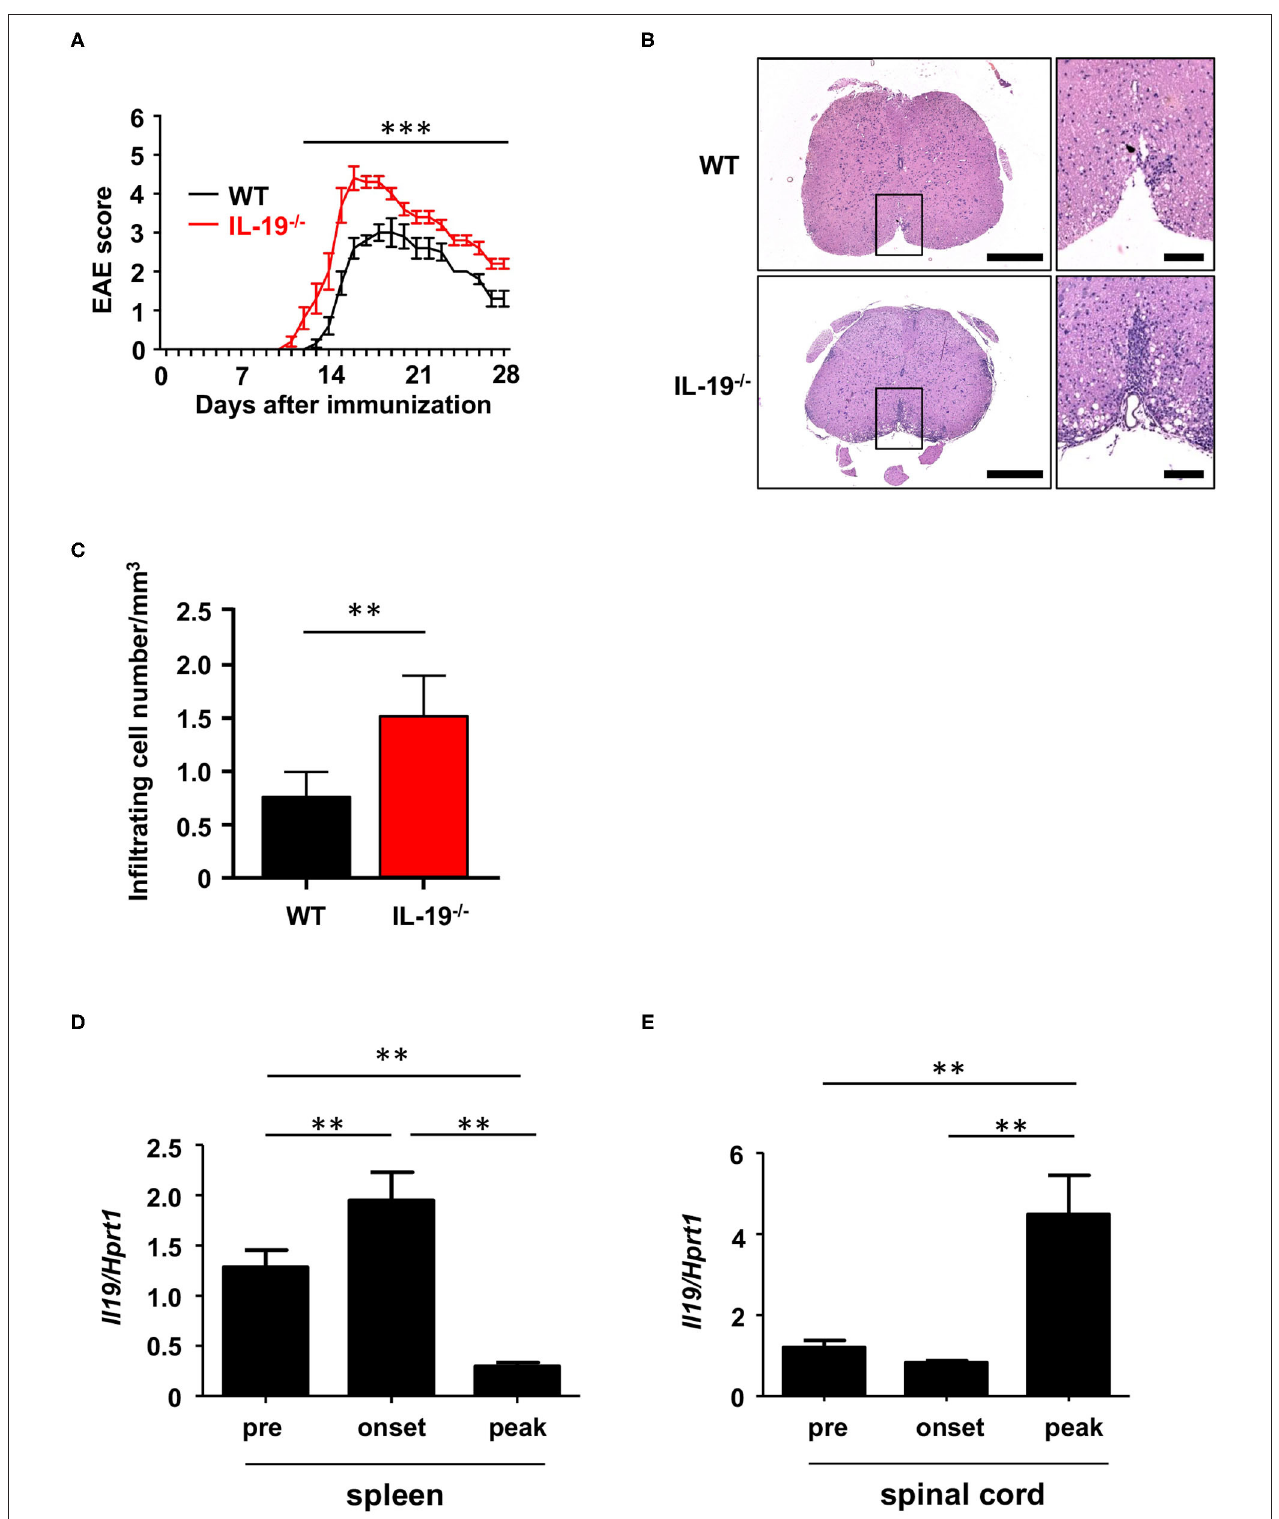
FIGURE 1 | IL-19 deficiency aggravates EAE. (A) EAE clinical scores for WT (black) and IL-19 − / − (red) mice. Statistical significance was analyzed using repeated measures ANOVA followed by post-hoc Tukey’s test. Data represent means ± SD ( n = 10). *** p < 0.0001. (B) Micrographs of hematoxylin/eosin staining of L5 lumbar